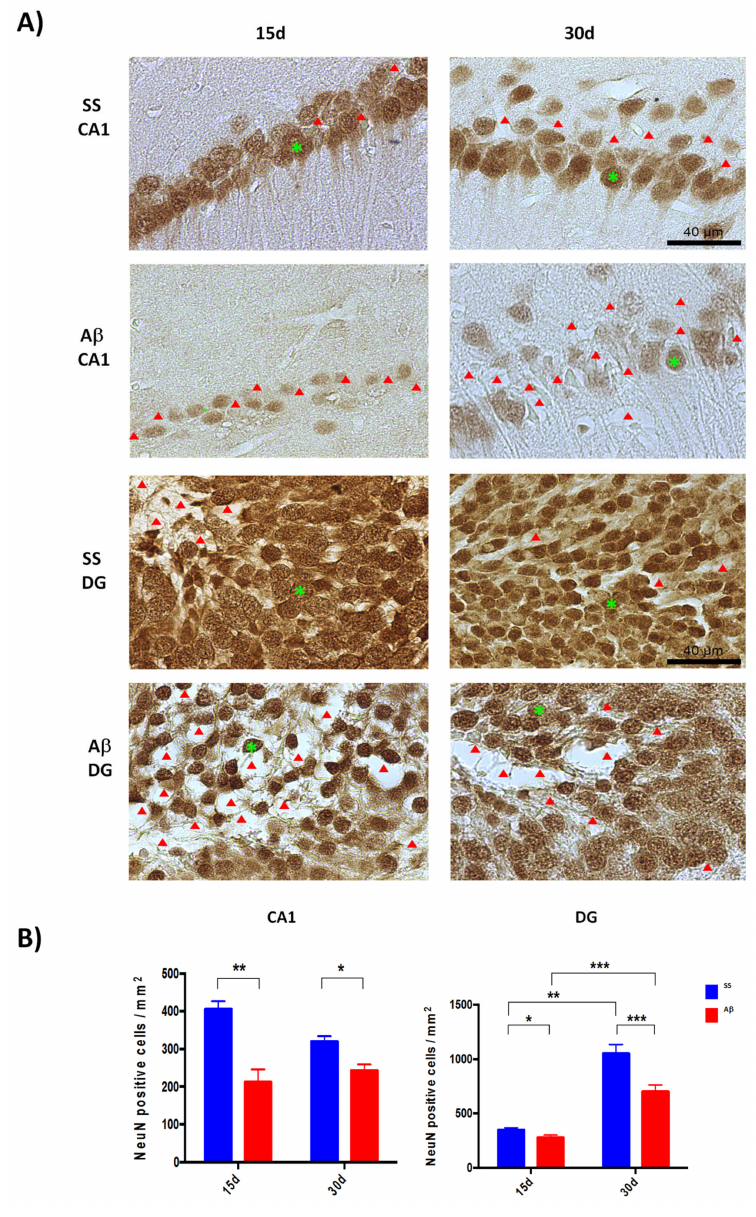
Figure 1. Quantification of degenerated neurons. FJB staining was used to identify neurons undergoing neurodegeneration in CA1 and DG. ( A ) Representative images (20 × ) of SS and A β rats sacrificed after 18 h, 72 h and 7 days are shown (Scale bar = 50 µ m, white arrows mark FJB positive cells). A β oligomers promote increased cell death in both regions more than SS. ( B ): Quantitative analysis ( n = 3) in CA1 show a higher FJB stain in oligomers rats at 18 h and decreased at 72 h. Meanwhile, in DG, FJB positive cells were only detected in A β rats sacrificed after 72 h. Data of FJB positive cells / mm 2 are presented as mean with the standard error of mean (SEM) bars. Significance level * p < 0.05 and ** p < 0.01, are